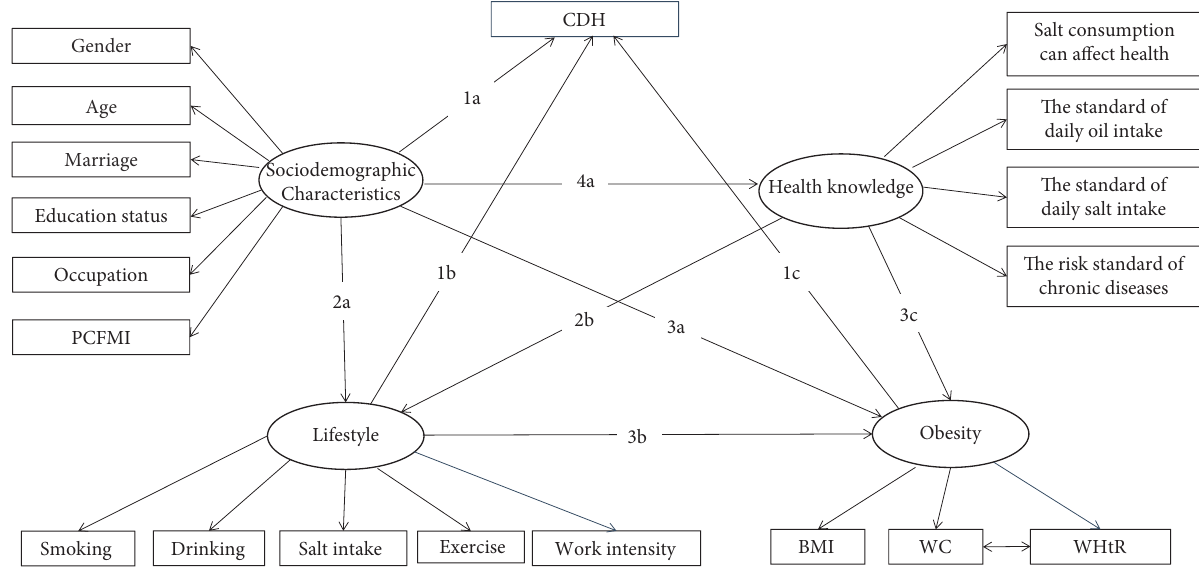
Figure 1: Base structural equation